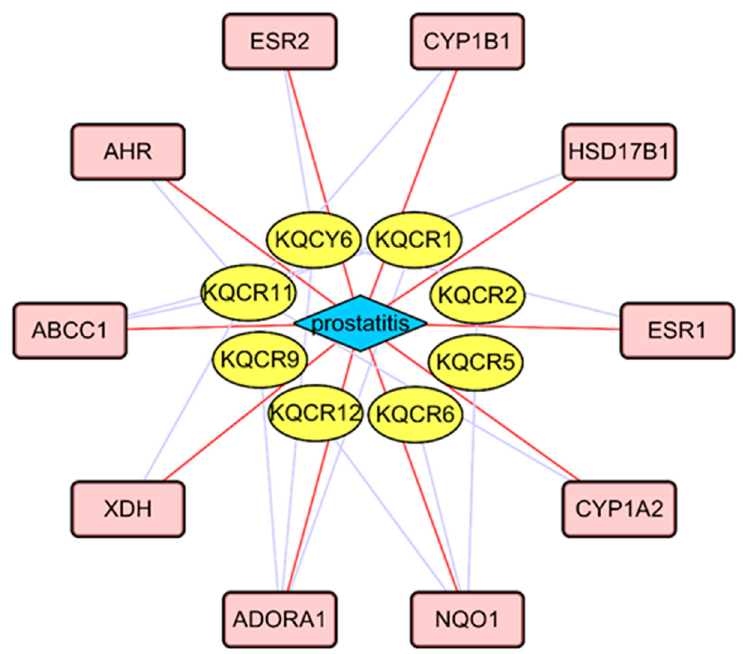
Figure 6. T. patula active compounds-target-prostatitis disease interaction.